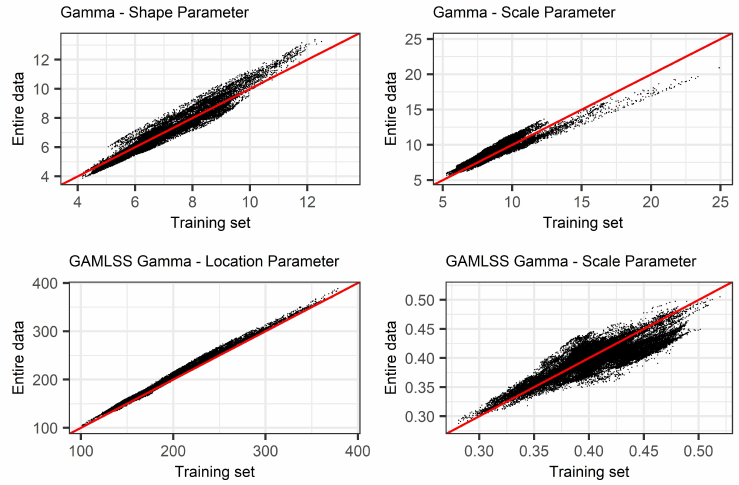
Figure A1. ( top ) Comparison between the stationary Gamma distribution parameter estimates (SPI); ( bottom ) Aggregated GAMLSS location and scale parameters of non-stationary Gamma (NSPI) of accumulated precipitation between Y ( 3 ) , ( k , l , m ) ( y -axis) and Y ( 3 ) , ( k ) ( x -axis) for 36,662 basins in Sweden during